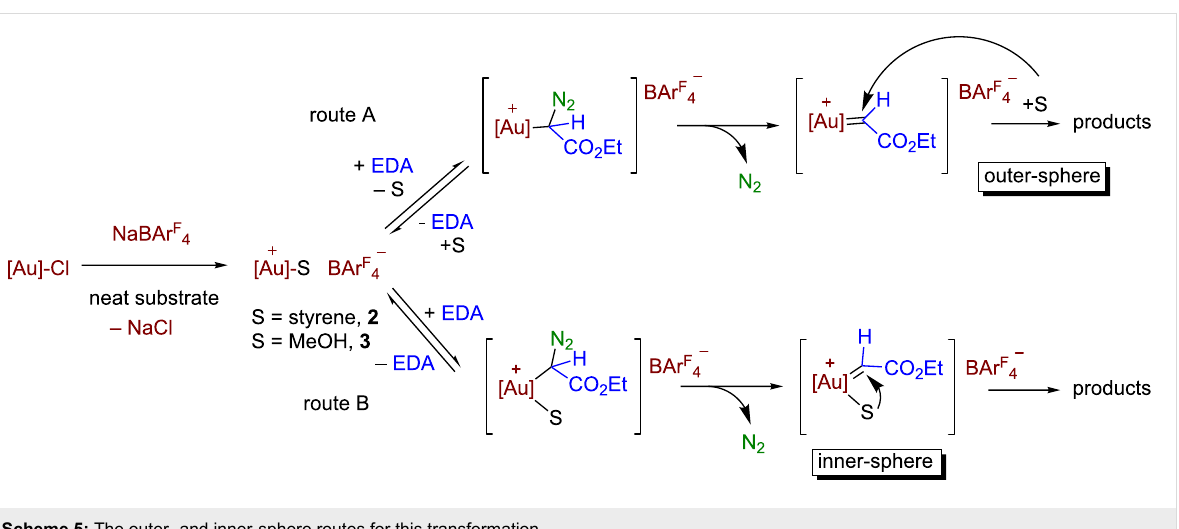
Scheme 5: The outer- and inner-sphere routes for this transformation.